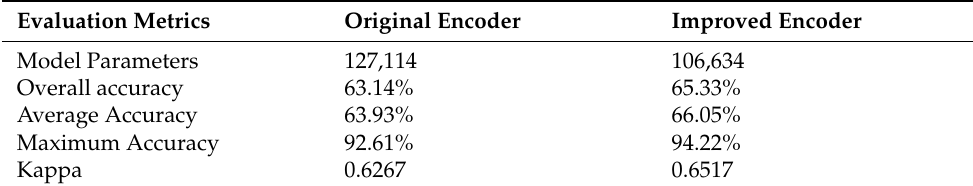
Figure 9. Classification accuracy of two types of encoders vs. SNRs. Table 3. Comparison of Evaluation Metrics of original Encoder and improved